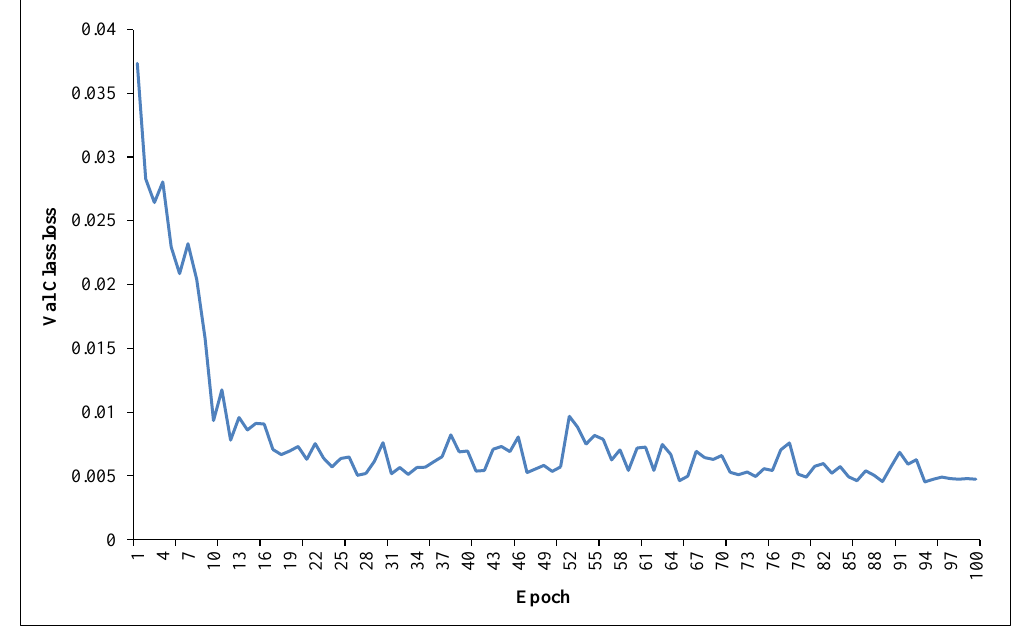
Figure 9. Yolov5s model validation class loss vs epochs